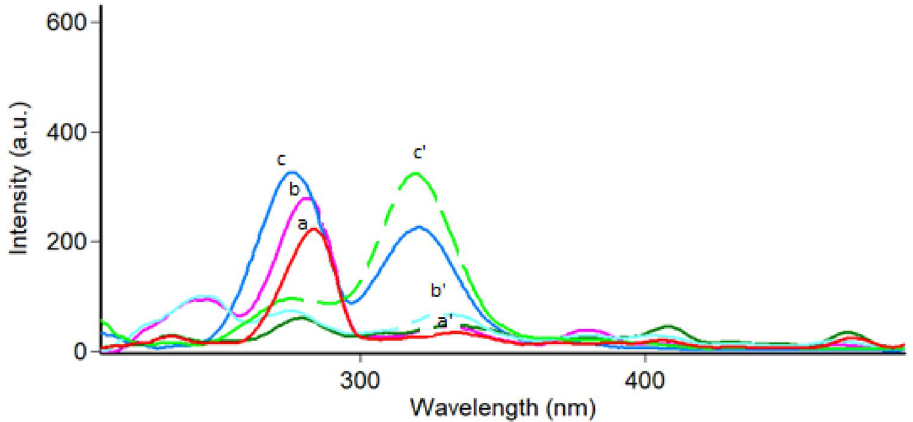
Figure 3. Effect of Δ λ on the relative synchronous fluorescence intensity of NEB (100.0 ng/ mL) and TEL (30.0 ng/ mL). where: (a, b, c) for Δ λ (15, 20, 40 nm), respectively for NEB (—) (a’, b’, c’) for Δ λ (15, 20, 40 nm), respectively for TEL (---).